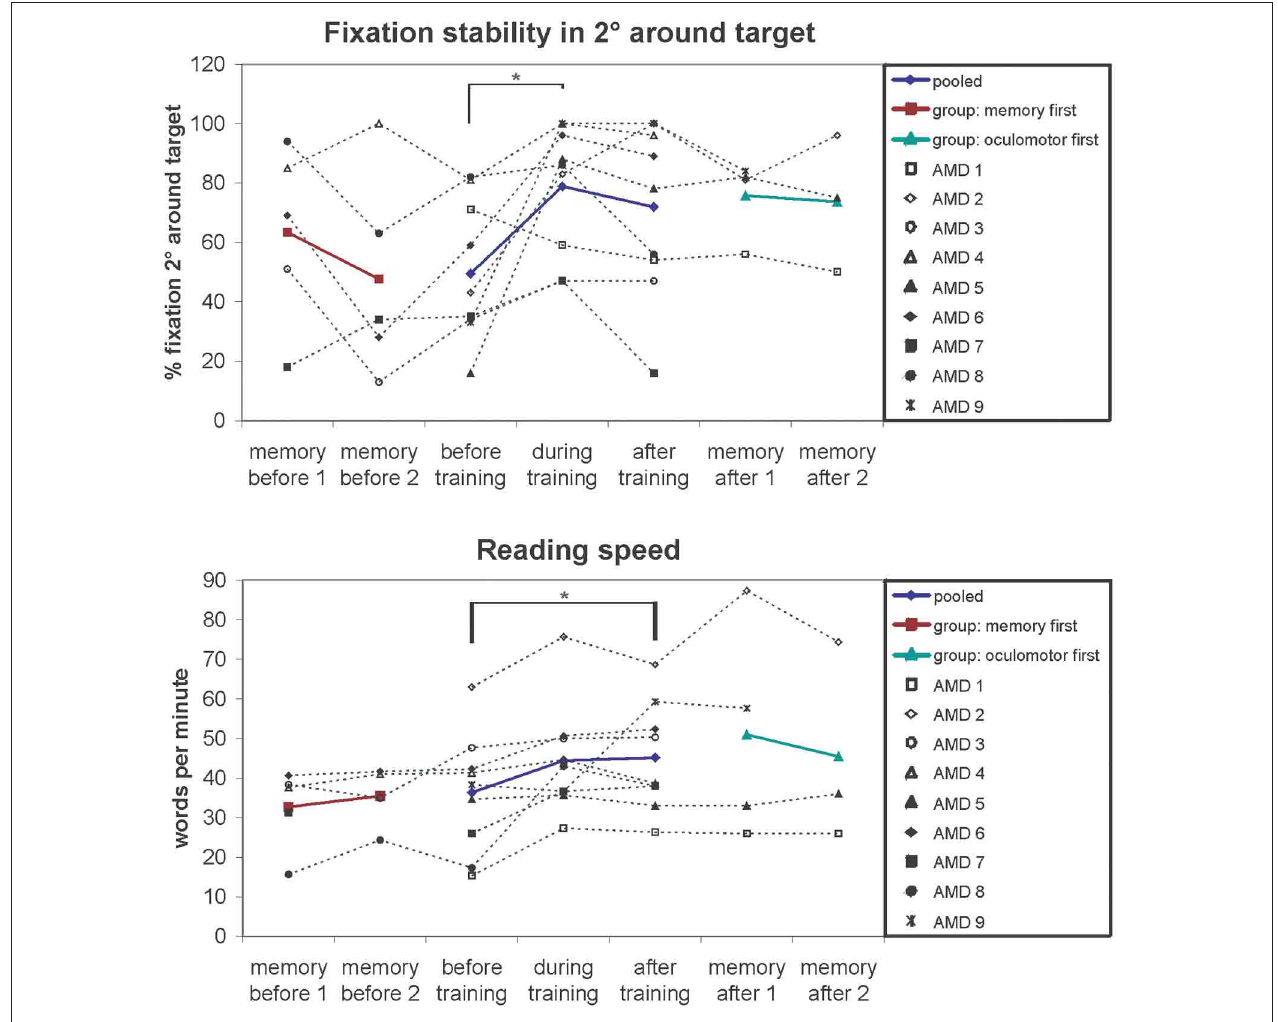
regardless of whether memory training was performed before (memory first p = 0 . 29) or after fixation training (memory after p = 0 . 93), ruling out non-specific placebo effects. A similar pattern can be observed for the reading speed. Reading speed increases over the 6 months of training